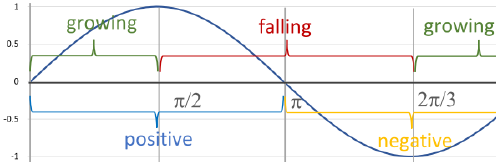
Figure 3. Detailed behaviour of the function sin